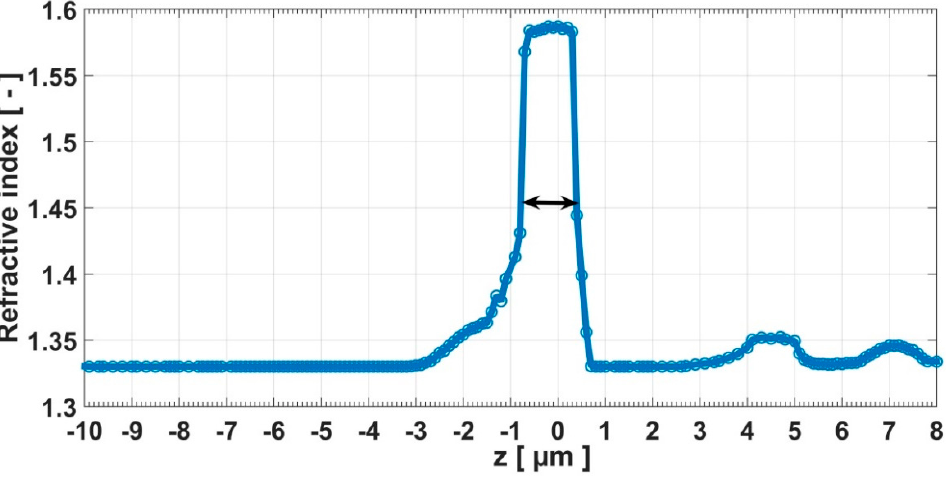
Figure 6. Mean values of the refractive index of the microsphere as a function of the z-position along the optical axis. The full width at half maximum (FWHM) indicated by the double arrow corresponds to the diameter of the microsphere.